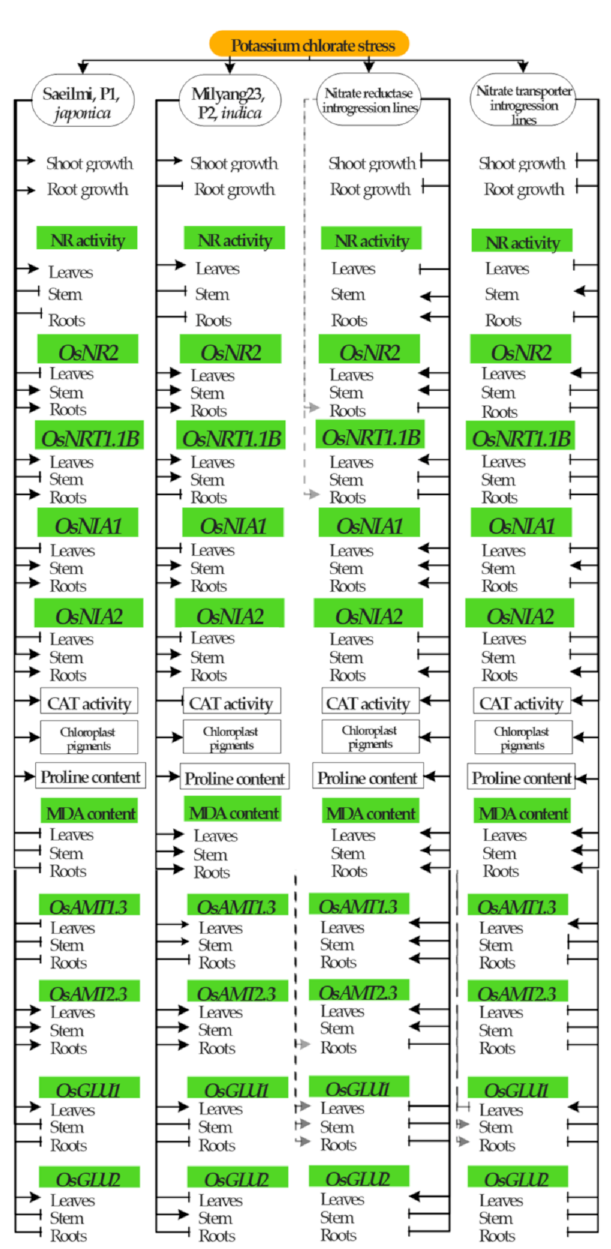
Figure 7. Signaling model summarizing the morphological, physio-biochemical, and molecular response of NR and NRT introgression rice lines towards potassium chlorate. The phenotypic re- sponses, the physiological and biochemical changes, as well as the molecular responses of the parental lines Saeilmi (P1, japonica ) and Milyang23 (P2, indica ) and their derived introgression lines (nitrate reductase or nitrate transporter, BC2F7) are summarized in the above signaling model. Continuous lines with an arrow indicate upregulation (for gene expression) or induction/increase (for enzyme activity or accumulation of physiological components). Continuous lines with a perpendicular bar indicate downregulation or inhibition/decrease. Dotted lines with or without an arrow or a perpendicular bar indicate that one of the introgression lines differentially expressed a particular gene in the corresponding rice tissue. This signaling model was created using ConceptDraw Pro v.10.3.2.114 (CS Odessa Corp, San Jose, CA,